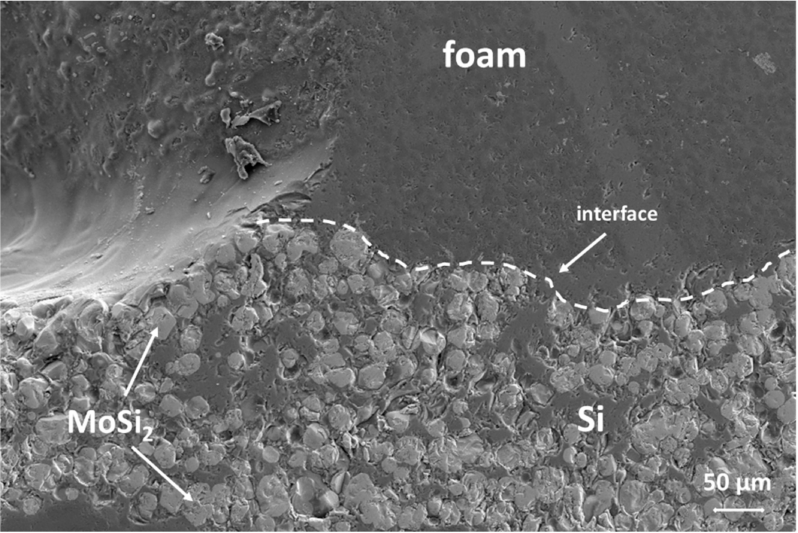
Figure 12. SEM image (BSE) of the interface between the foam and the joining material; on the left, a pore in the foam structure can be detected, while a magnification of a foam leg connected to the joining material is visible on the right.